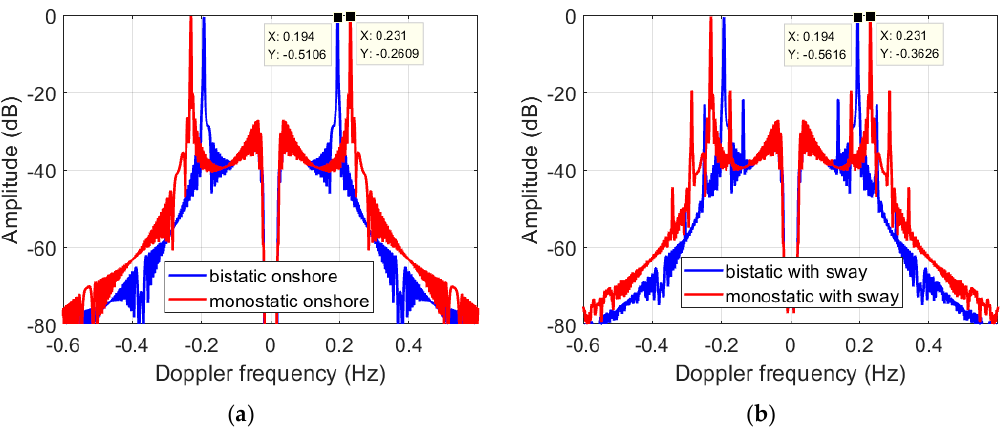
Figure 4. Simulated first-order radar cross sections (RCSs), ( a ) for onshore monostatic and bistatic cases; ( b ) for floating-based monostatic and bistatic cases with sway.